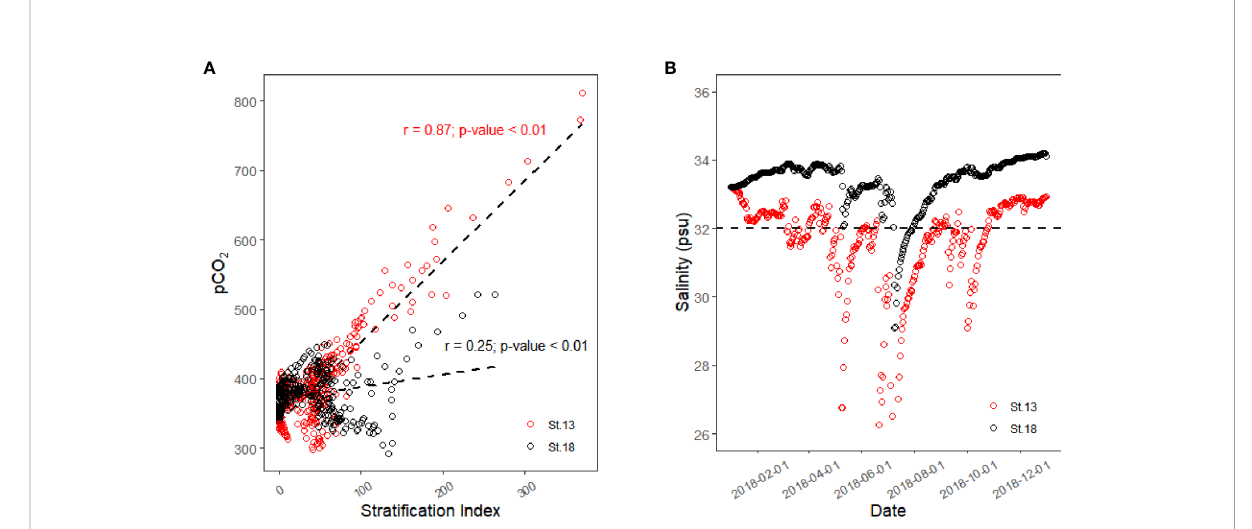
FIGURE 6 Linear correlation between surface pCO 2 and strati fi cation index (A) and surface salinity of St.13 and St.18 in 2018 (B)